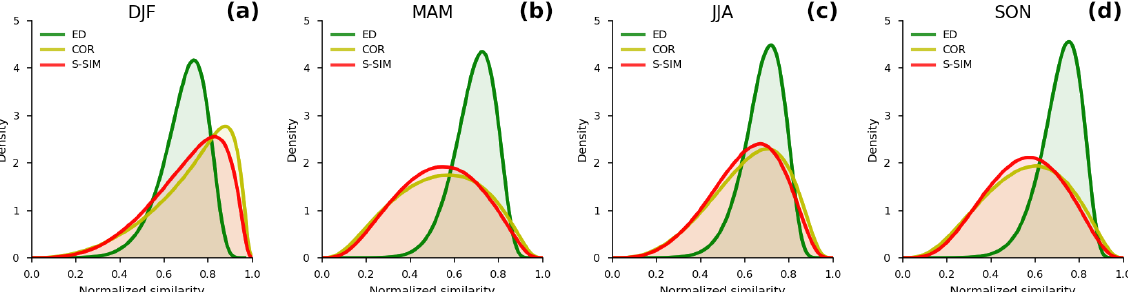
Figure 3. Comparison of probability density distributions (PDDs) of normalized inter-sample similarity using the structural similarity (S- SIM), the Pearson correlation coefficient (COR), and the Euclidean distance (ED) for four-season data. The inter-sample similarity values indicate similarity (or difference) between all pairs. With a population size of N , one has (N − 1 ) ! values, as S-SIM, COR, and ED are symmetric measures. Values are normalized from 0 to 1, i.e., s i = (s i − min { s } )/( max { s }− min { s } ) , with i = 1 , 2 ,...N . The maximum similarity is 1, i.e., completely similar, and the minimum similarity is 0, i.e., the lowest similarity between a pair of data points. Note that the minimum similarity is dependent on a similarity measure and data (DJF, MAM, JJA, or SON)